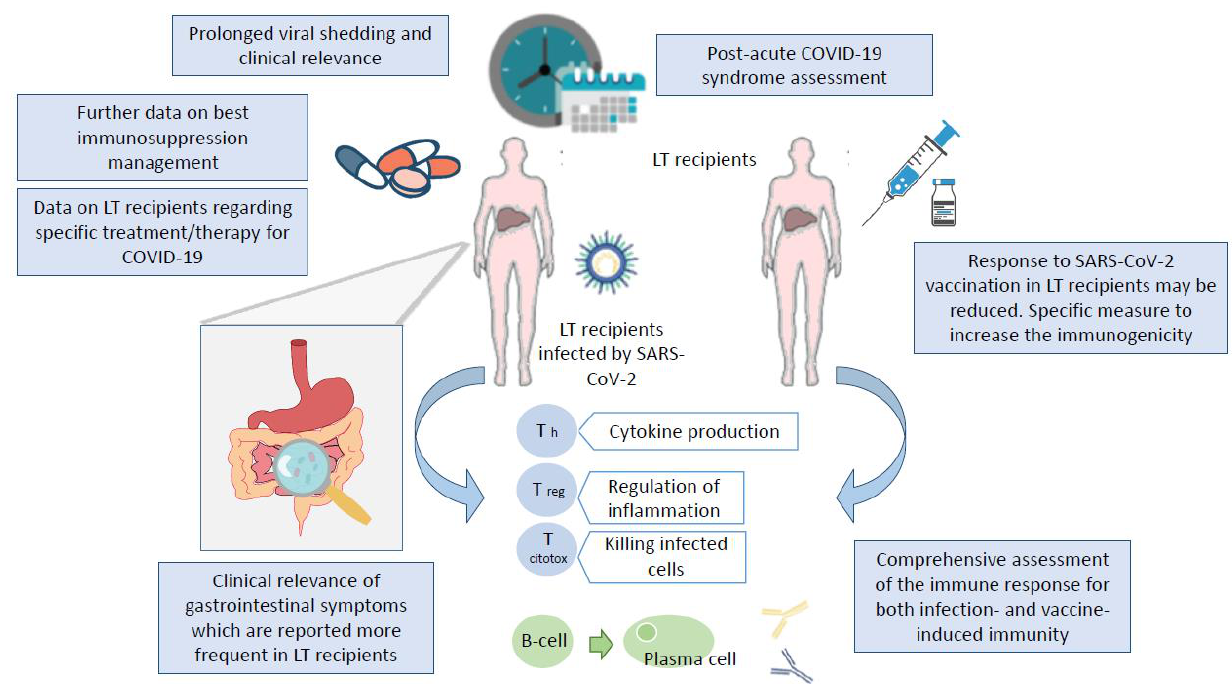
Figure 2. Graphical representation of the key unresolved issues for SARS-CoV-2 infection in LT recipients.